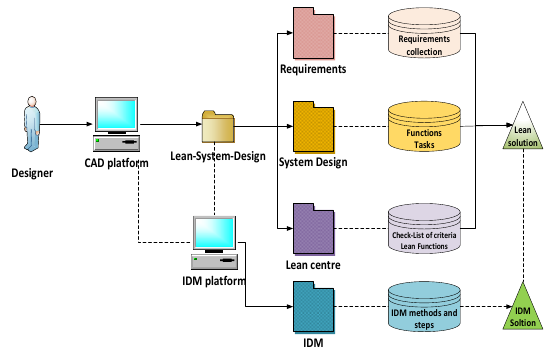
Figure 4. Architecture of Lean-System-Design